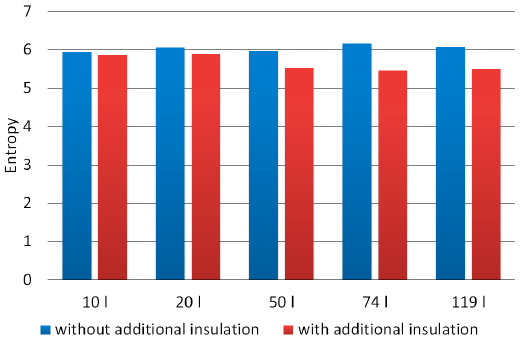
Figure 8. Entropy averaged for images of composted material in the grayscale.